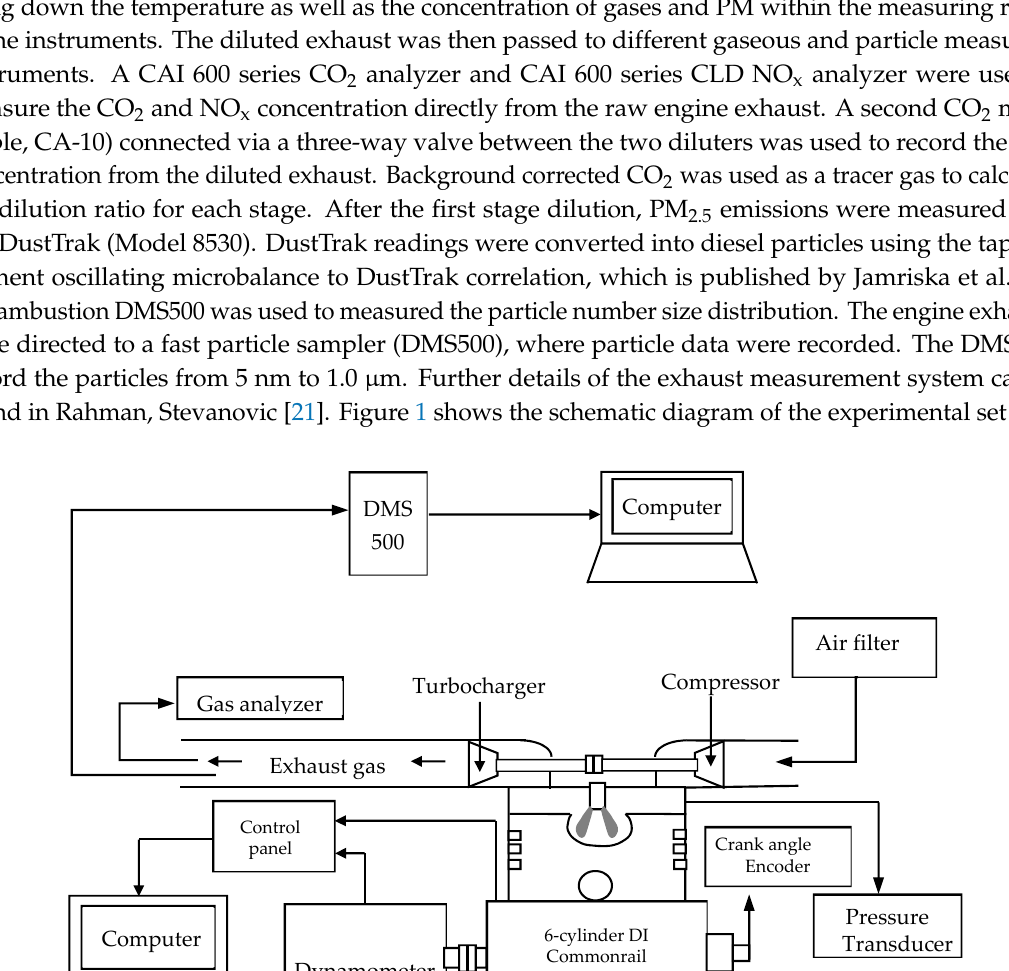
Table 1. Engine specifications.